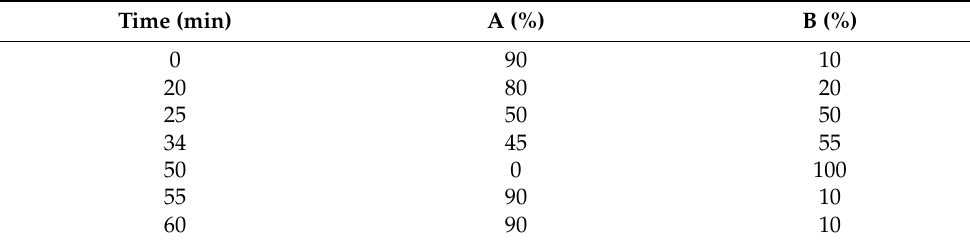
Table 2. The gradient elution of free amino acids.